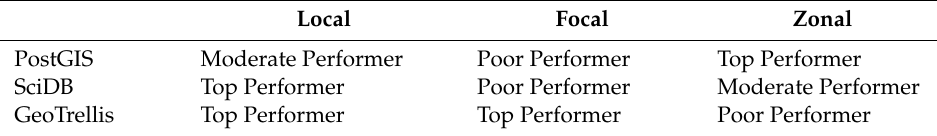
Table 11. Evaluation of platform performance on raster